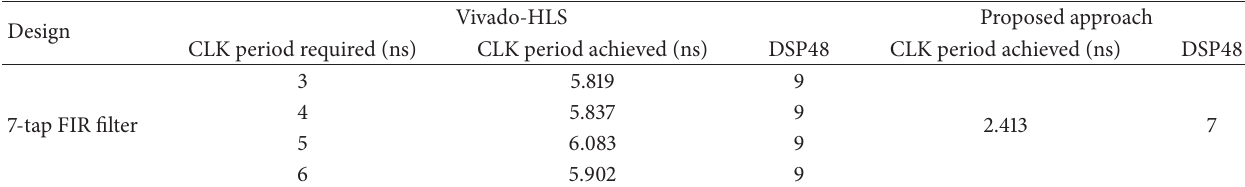
Table 11: Result comparison between Vivado-HLS and proposed approach for 7-tap FIR